Question: Provide a publication-style caption for this figure.
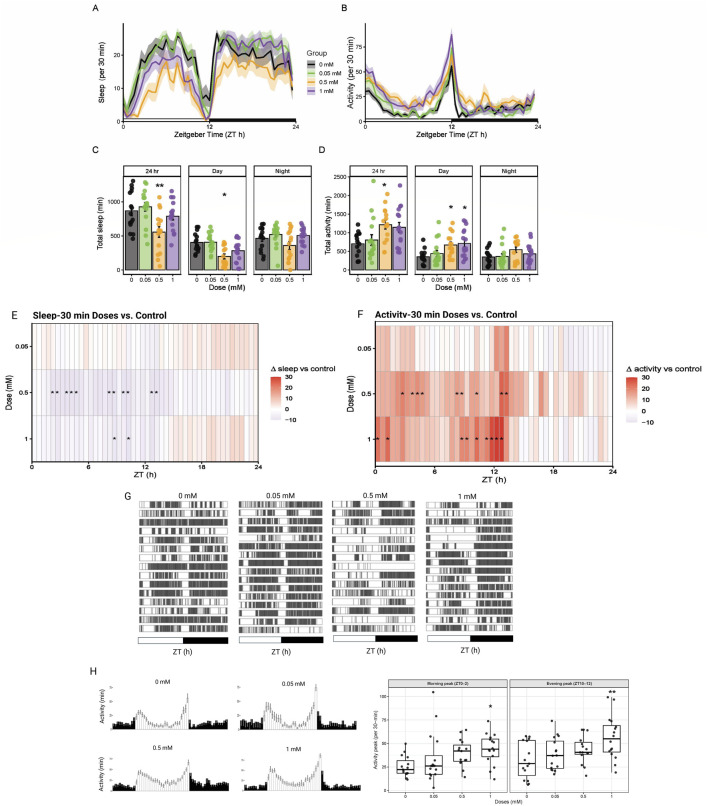
Answer: Simvastatin decreased sleep and increased the locomotor activity on the third day and with mainly effect on the midday siesta. (A,B) Sleep and activity profiles under 12:12 h, light: dark condition. Mean ± SEM sleep is shown for each dose (0.0, 0.05, 0.5, 1.0 mM). White bars indicate daytime (ZT 0–12); black bars indicate night-time (ZT 12–24). (C,D) Total sleep in 24 h, daytime and nighttime. Bars show mean ± SEM. Significant sleep reductions were observed at 0.5 mM during 24 h (p = 0.006) and daytime (p = 0.012). Total locomotor activity in 24 h, daytime and nighttime. Activity significantly increased at 0.5 mM compared to control during 24 h (p = 0.040); during daytime 0.5 mm (p = 0.033) and 1. mM (p = 0.021) differing from control (0.0 mM). (E–F) Sleep difference heatmap (doses vs. control). Red colors indicate increased sleep relative to control. Blue colors indicate reduced sleep (sleep loss). Nighttime (ZT 12–24) is shaded. Asterisks mark ZT bins with significant differences ( p < 0.05). Red colors indicate higher activity relative to control; blue colors indicate lower activity. (G) Raster plots showing the sleep-wake pattern of individual flies treated with simvastatin with various concentration during a 24 h (12 h:12 h dark: light) period. White regions indicate wakefulness - defined as movement or inactivity lasting less than 5 min - whereas black regions denote sleep, characterized by inactivity lasting longer than 5 min. Control flies’ group (0.0 mM), n = 15. Different doses of simvastatin: 0.05 mM, n = 16; 0.5 mM, n = 15; 1.0 mM, n = 16. (H) Left: activity pattern for the control group (0.0 mM) and different doses of simvastatin. Right: Morning activity peak was significantly increased at 1 mM (p = 0.011); while Evening activity peak was significantly increased at 1 mM (p = 0.002). Each point represents an individual fly; Boxes represent the first and third quartiles, the center line indicates the median, and whiskers extend to 1.5 x the interquartile